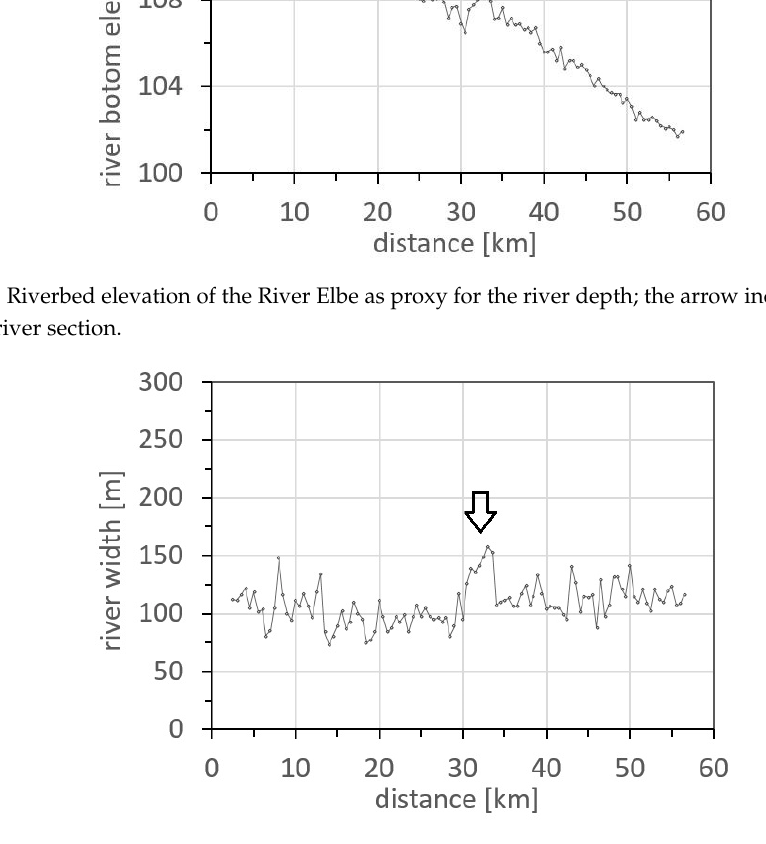
Figure 3. Width of the River Elbe including one-point anomalies such as small harbours and natural embayment; the arrow indicates a major wide river section.